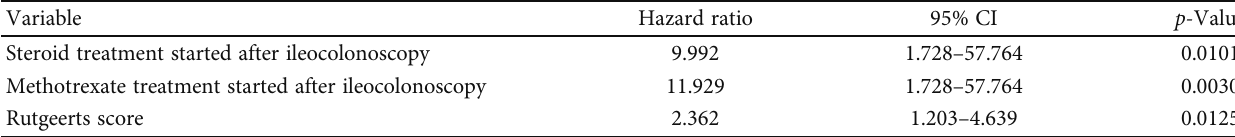
Table 4: Predictive factors of postoperative surgical recurrence multivariate analysis in patients with post-operative ileocolonoscopy.